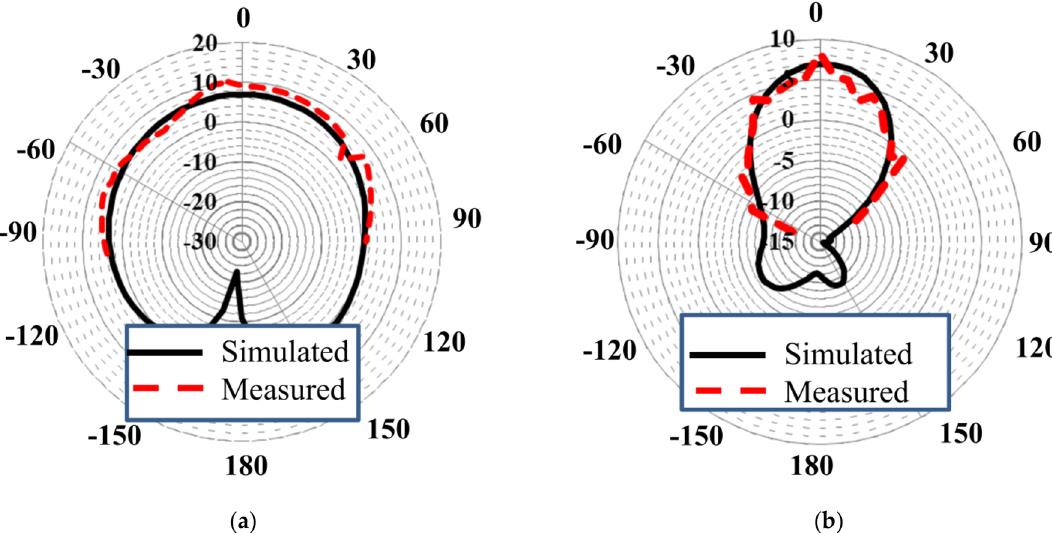
Figure 5. Radiation patterns in the ( a ) E-plane and ( b )